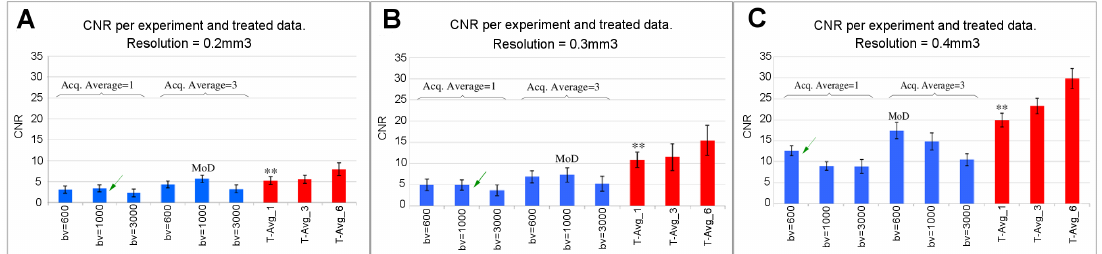
Figure 8: CNR measurements in FA maps of individual acquisitions and improved images. The last bar (T-Avg_6) corresponds to the subject with improved image quality using all the available data per resolution (replicating a possible longitudinal study framework). The blue bars in each frame correspond to individual acquisitions and are labeled with their b-values and number of acquisition averages. We include the results of processing all the data with one (T-Avg_1) or three (T-Avg_3) averages at a given resolution. Bars labeled with ∗∗ correspond to processed data with the same acquisition time as their associated MoD image, thus fairly